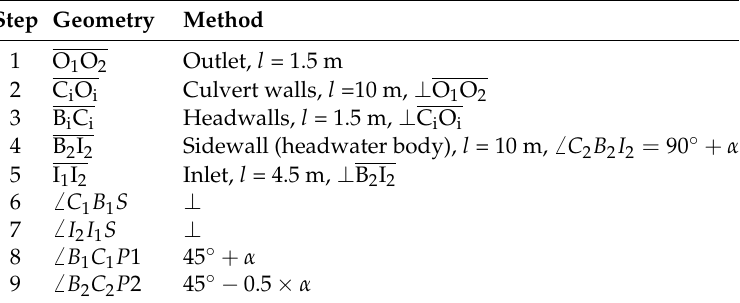
Figure 1. Geometry explanation used for all computational fluid dynamics (CFD) simulations. C 1 C 2 O 2 O 1 outlines the culvert, B 1 B 2 I 2 I 1 S outlines the upstream water body ( a ) example geometry with α = 30 ◦ , ( b ) no misalignment with α = 0 ◦ , ( c ) greatest misalignment with α = 90 ◦ (dotted lines in ( b , c ) indicate the chamfer -configuration). Table 1. Geometry construction for CAD and flume